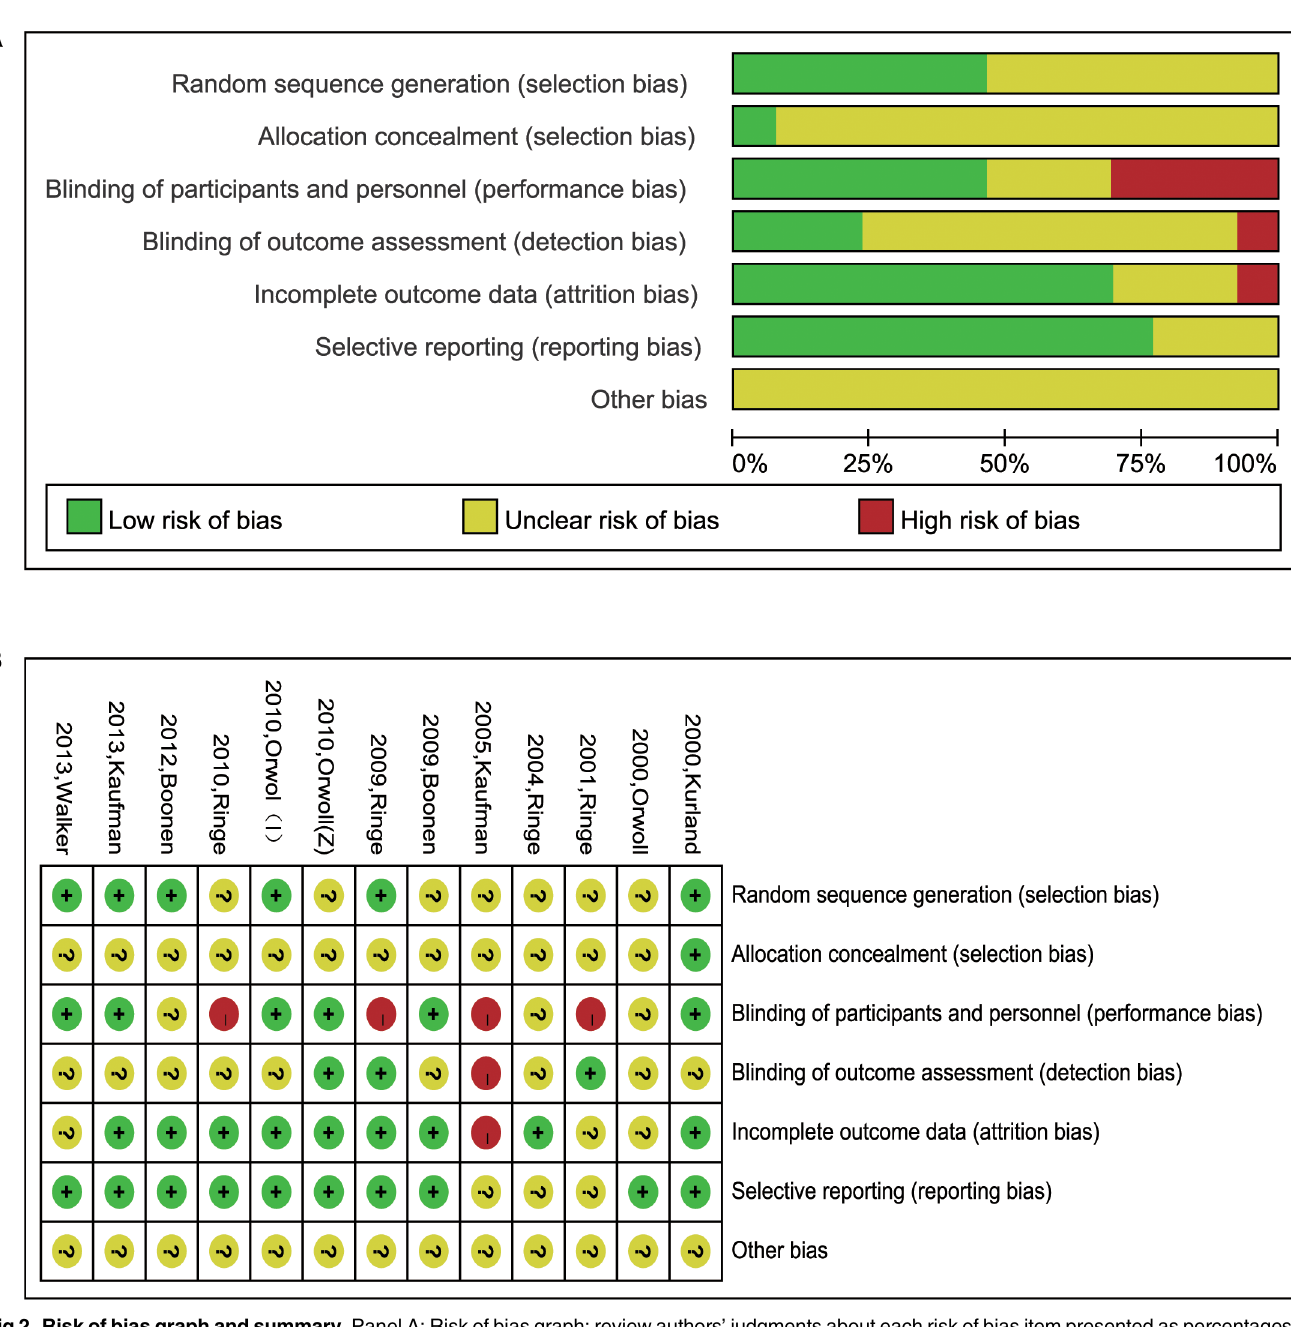
PLOS ONE | DOI:10.1371/journal.pone.0128032 May 26,